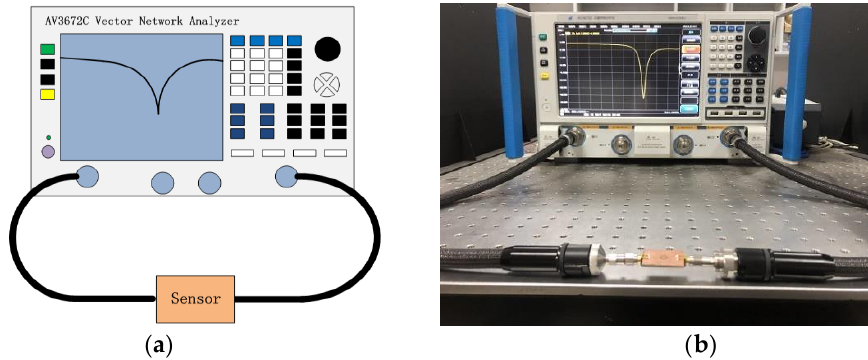
Figure 4. ( a ) Schematic diagram of the proposed microwave sensing system used to identify different materials and determine the corresponding concentration; ( b ) Photograph of the setup of the measuring experiment.